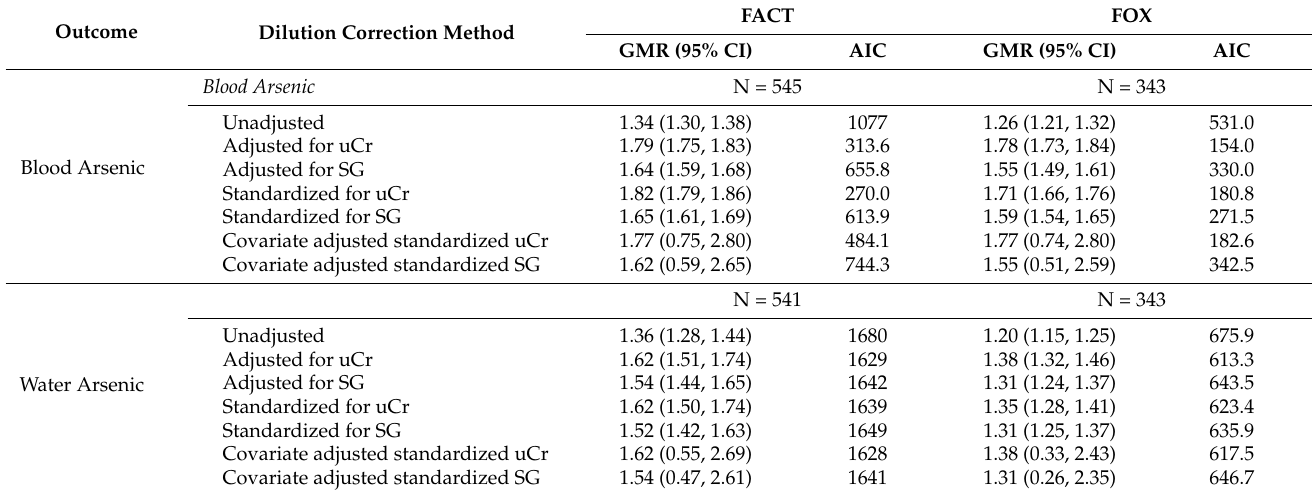
Table 2. Geometric mean ratio for blood and water arsenic levels per two-fold increase in urine arsenic levels.